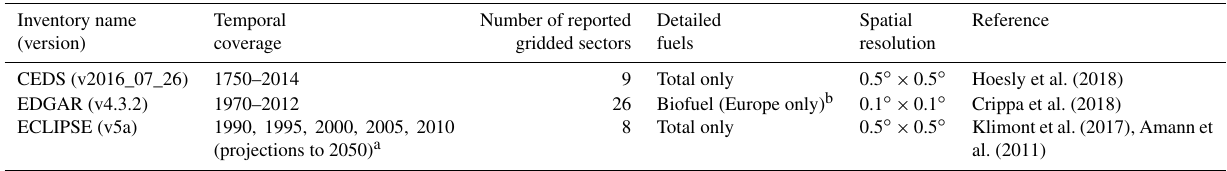
Table 1. Comparison of three historical, gridded, source-specific emission inventories of atmospheric pollutants (NO x , SO 2 , CO, NMVOCs, NH 3 , BC,